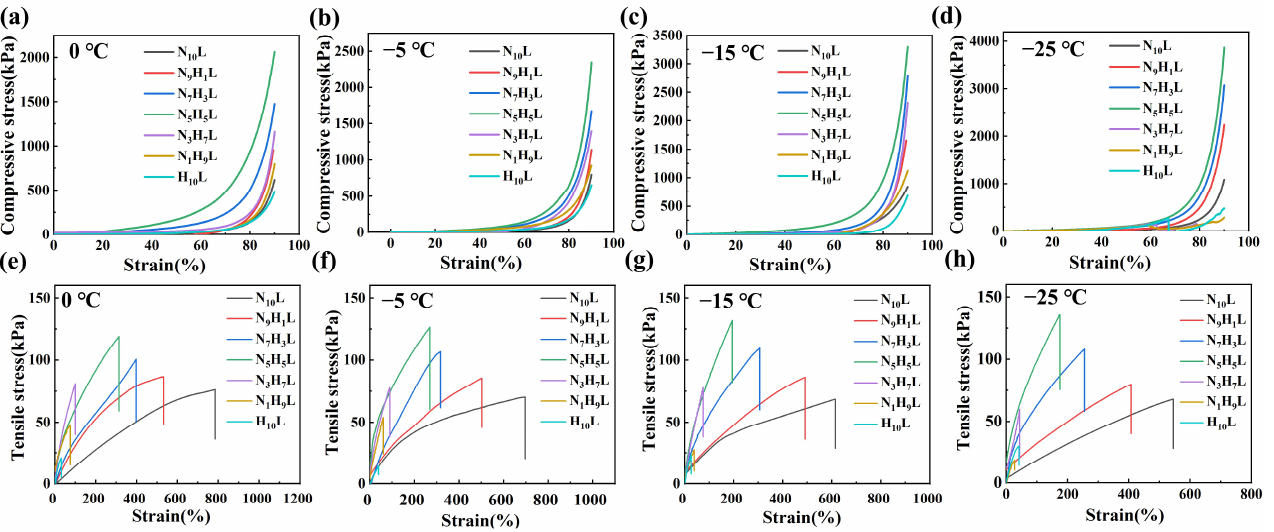
Figure 8. The compressive and tensile stress–strain diagrams of the NC organohydrogels after be- ing placed at different low temperatures for 12 h and tested returned to room temperature: ( a , e ) 0 °C; ( b , f ) −5 °C; ( c , g ) −15 °C; ( d , h ) −25 °C; respectively. ( b , f ) − 5 ◦ C; ( c , g ) − 15 ◦ C; ( d , h ) − 25 ◦ C;